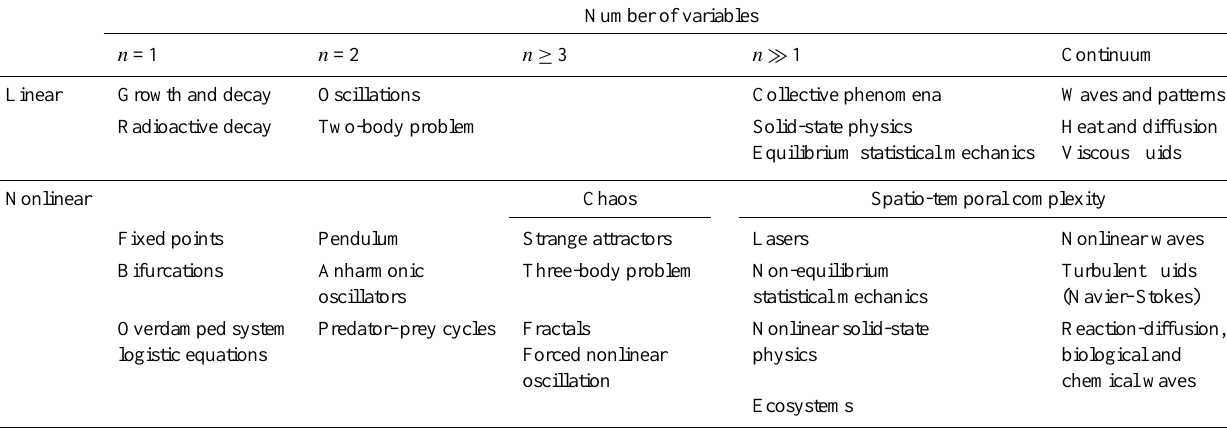
Table 1. Classification of dynamical systems (simplified from Strogatz, 1994, p. 10, Fig. 1.3.1). Number of variables n =1 n =2 n ≥ 3 n (cid:29) 1 Continuum Linear Growth and decay Oscillations Collective phenomena Waves and patterns Radioactive decay Two-body problem Solid-state physics Heat and diffusion Equilibrium statistical mechanics Viscous fluids Nonlinear Chaos Spatio-temporal complexity Fixed points Pendulum Strange attractors Lasers Nonlinear waves Bifurcations Anharmonic Three-body problem Non-equilibrium Turbulent fluids oscillators statistical mechanics (Navier–Stokes) Overdamped system Predator–prey cycles Fractals Nonlinear solid-state Reaction-diffusion, logistic equations Forced nonlinear physics biological and oscillation chemical waves